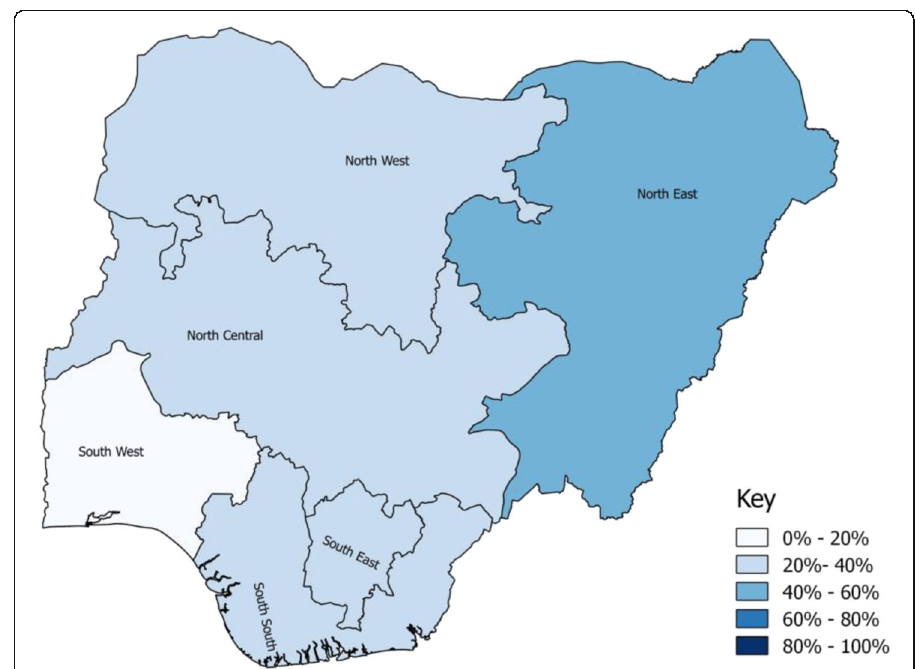
Fig. 4 Percentage of women believing that a husband is justified in beating his wife if she goes out without telling him, by region, NDHS 2013